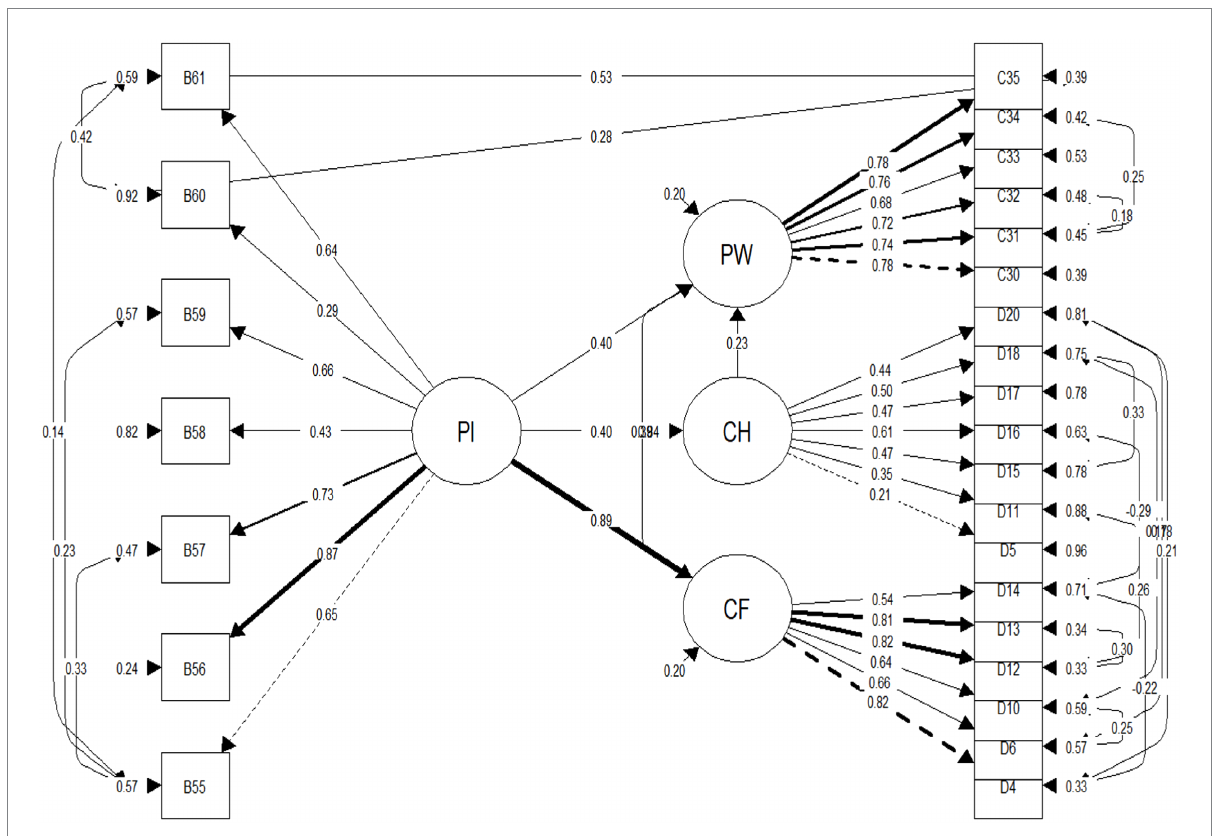
FIGURE 2 Double mediation model with the introduction of item correlatedness. Item correlatedness is depicted to the left and right of the indicators (items). The item correlatedness mostly correspond to the facet level of PI (personal power, self-esteem, sense of purpose, and positive view of personal future), confidence, and character. Only standardised latent variables values are reported. PI, positive identity; CF, confidence; CH, character; PW, psychological